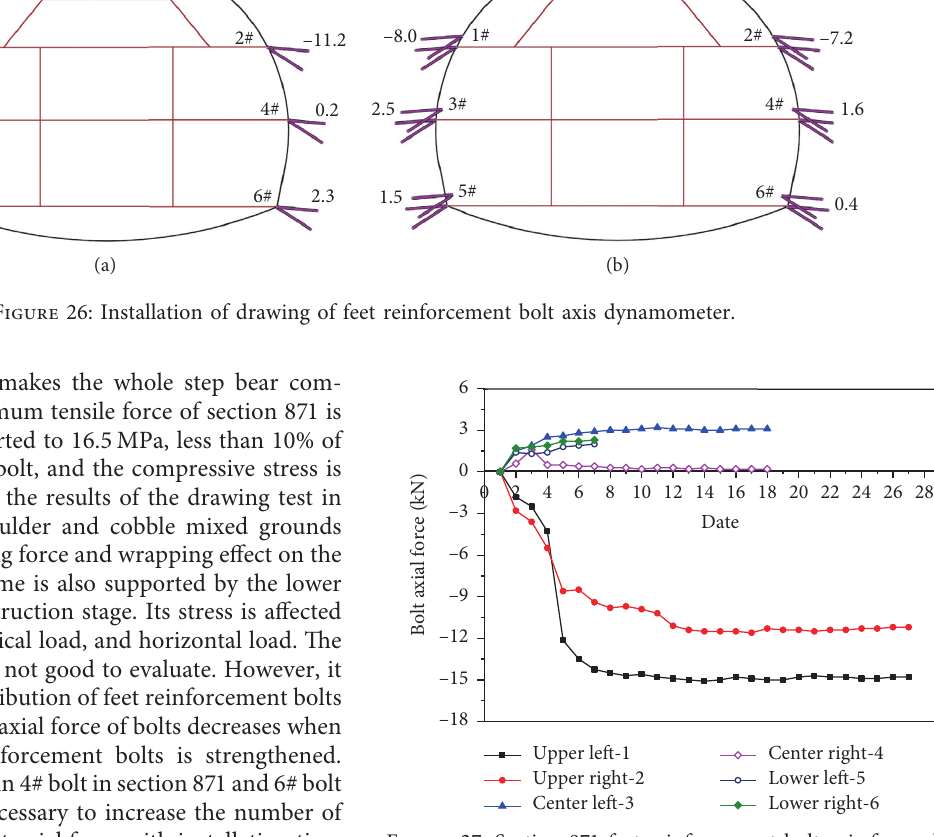
Figure 27: Section 871 feet reinforcement bolt axis force change curve.